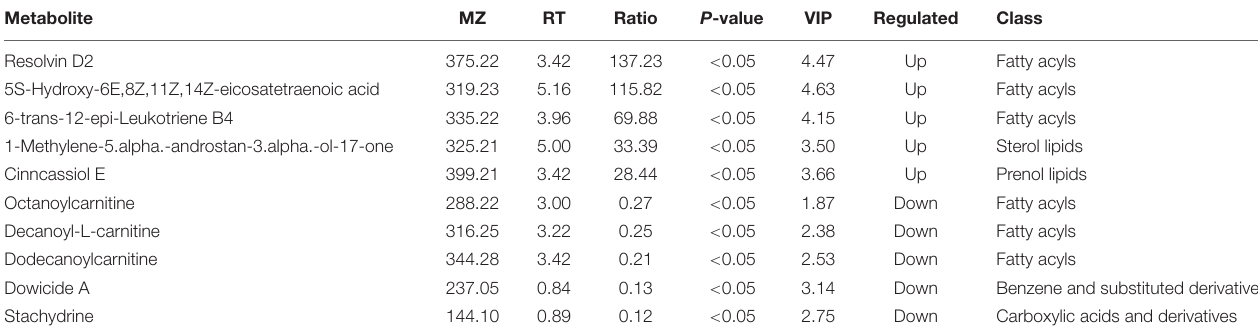
TABLE 2 | The metabolites were screened by some parameters. Metabolite